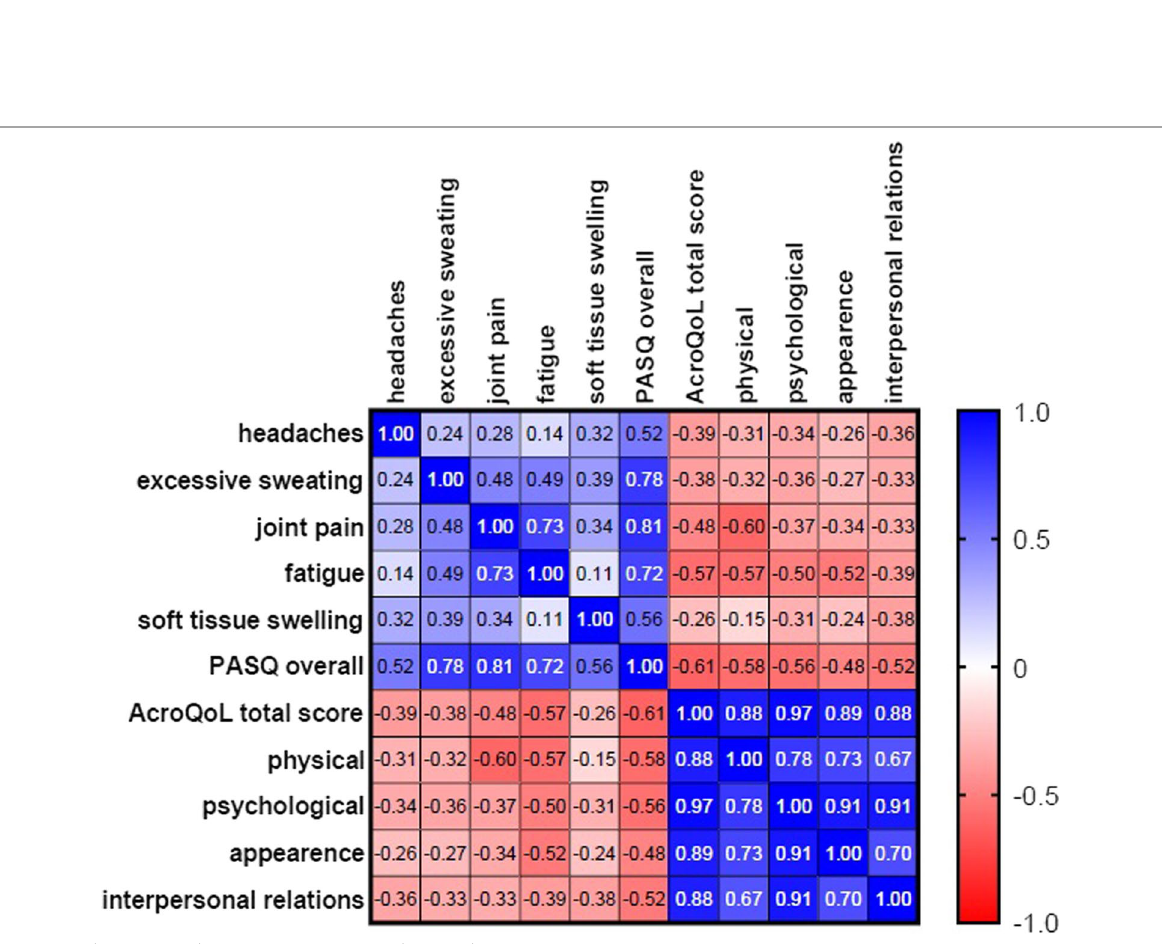
Fig. 3 Correlation matrix between PASQ scores and